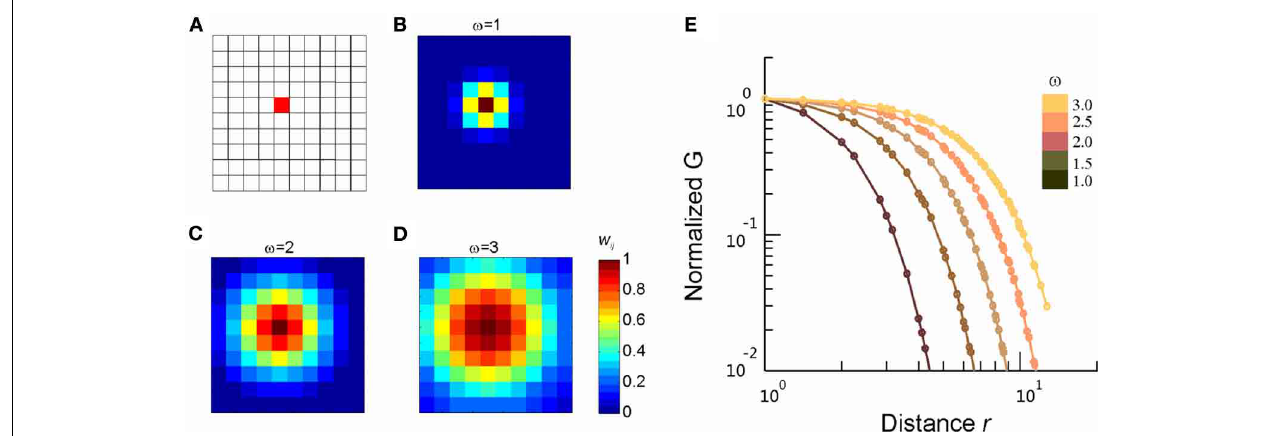
FIGURE A2 | Volume conduction does not introduce long-range between site i and j . (A) Spatial configuration of the simulated array. correlations. In a simulated 10 × 10 array configuration, we introduce (B–D) , For an example site (the red square in A ), the mixing weight volume conduction by mixing the independent signals from nearby sites w ij (color corded) with different spatial extend ( ω ) are shown, with the (cid:8) w ij S j , where S represents independent signals reference to the whole array. (E) Correlation, G , between mixed according to S (cid:11) i = from individual site and S’ represents the signals after mixing. The activities are plotted as a function of the separation distance for different ω (color-coded). To facilitate comparison, G is normalized by mixing weight w ij = exp , where r ij is the distance the correlation between the nearest neighbors, i.e., r =